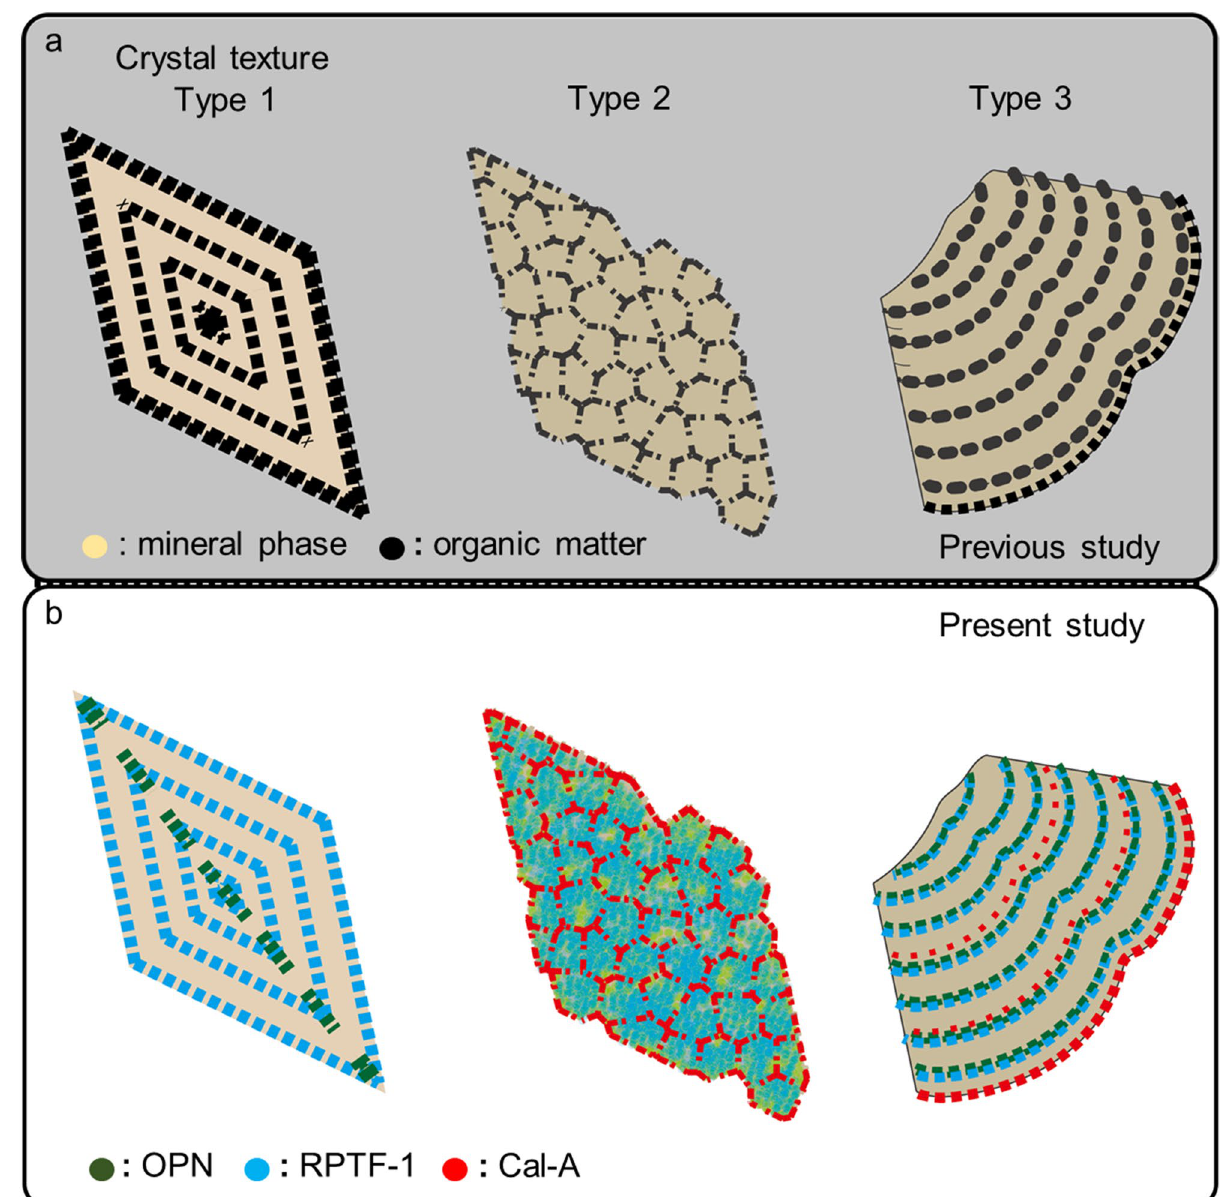
Figure 7. Schematics of the protein distribution in three major texture in CaOx. ( a ) Protein matrix distribution regarded in previous studies (white color: mineral phase black color: organic matter). ( b ) Specific protein distribution found in the present study (green: osteopontin (OPN), blue: renal prothrombin fragment 1 (RPTF- 1), and red: calgranulin A (Cal-A). Type1 idiomorphic COD, Type2 mosaic COM, and Type3 concentrically laminated